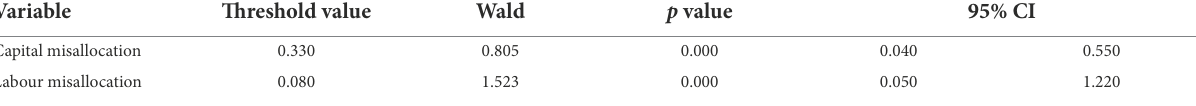
TABLE 5 The threshold